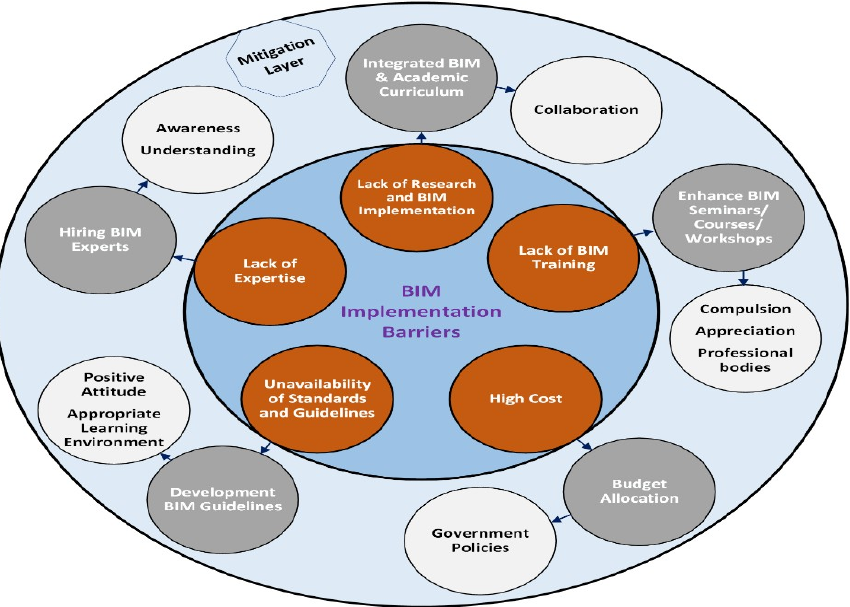
Figure 3. BIM-based research framework incorporating barriers and strategies for sustainable building projects. building